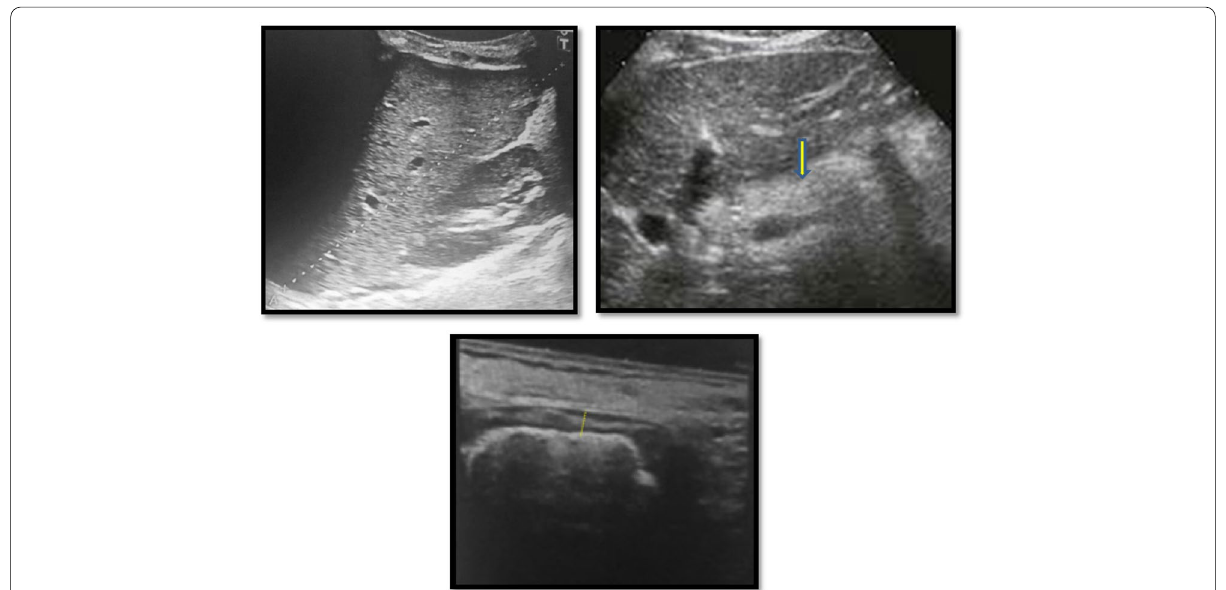
Fig. 2 A child known to have cystic fibrosis. She was complaining of chronic cough, recurrent abdominal pain, failure to thrive, and steatorrhea improving on pancreatic enzyme replacement therapy. Her labs are as follows: ALT, 19; AST, 25; Na, 138; K, 3.6; and random blood glucose, 130. Ultrasound of the abdomen shows heterogeneous liver parenchyma with hepatomegaly measuring about 14.7 cm, increased pancreatic echogenicity (pancreatic lipomatosis, arrow), and increased small bowel wall thickening measuring up to 0.5 cm